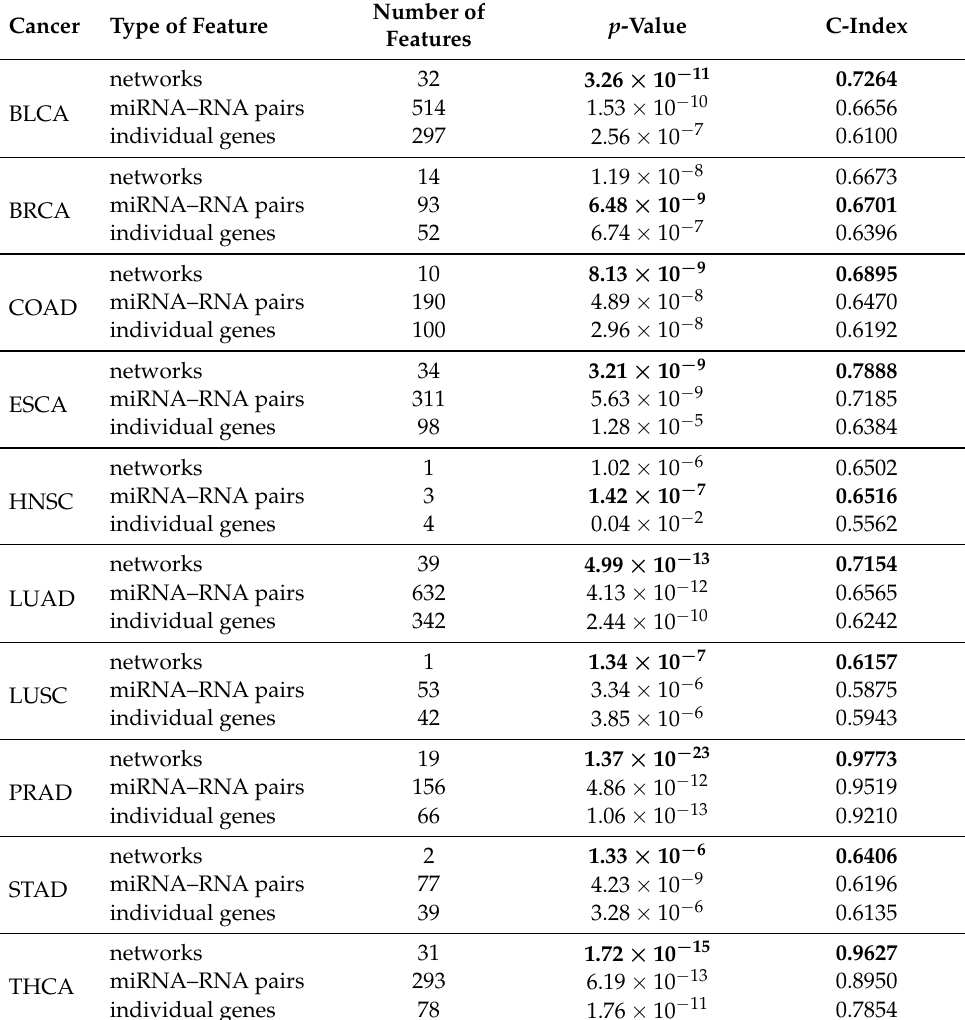
Table 7. The number of features and the best p -value and C-index for each cancer type in subnetworks, miRNA–RNA pairs, and individual genes. Bold values indicate best